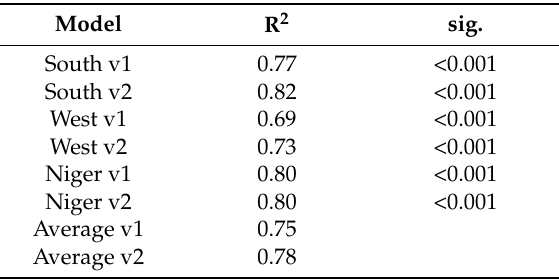
Table 5. Soil Moisture Validation against ESA CCI Data.